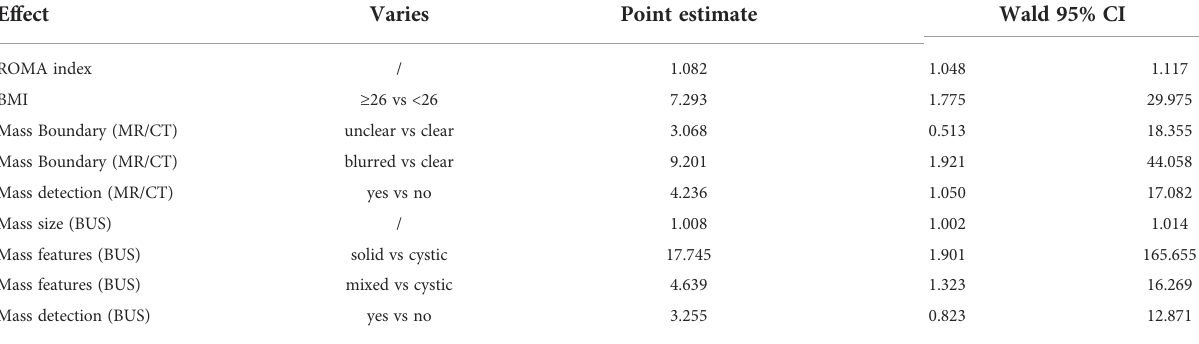
TABLE 2C Multivariate logistic regression